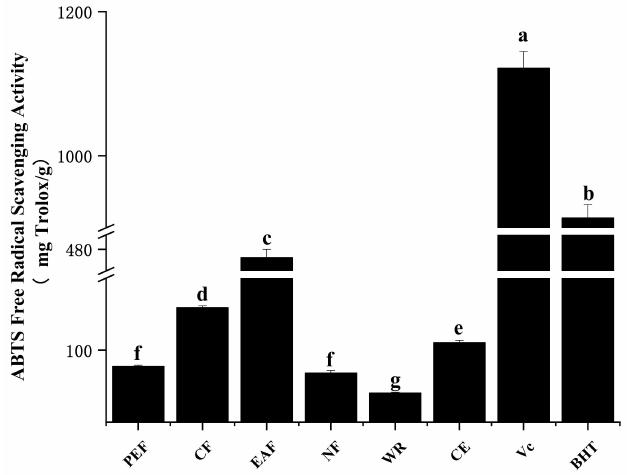
Figure 2. The ABTS radical scavenging ability of samples. The different letters in the column represented significantly difference ( p <